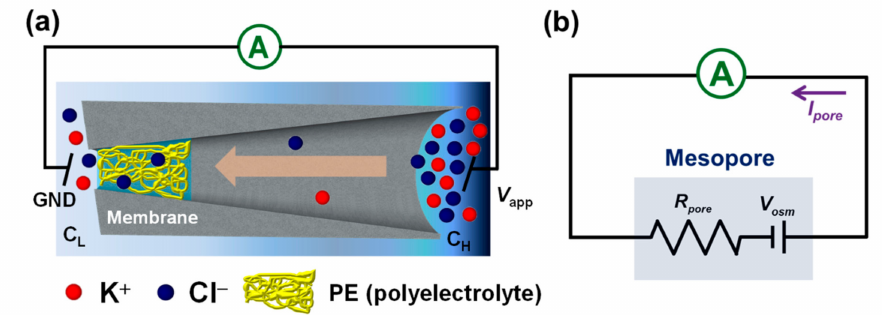
Figure 1. ( a ) Schematic depiction and ( b ) the corresponding equivalent electric circuit of the mesoscale osmotic energy harvesting system under consideration. The electrode in the low concentration reservoir is grounded (GND), while is applied at a voltage V app in the high concentration reservoir. R pore is the pore resistance, V osm is the osmotic voltage caused by a concentration gradient across a mesopore, and I pore is the generated ionic current through the